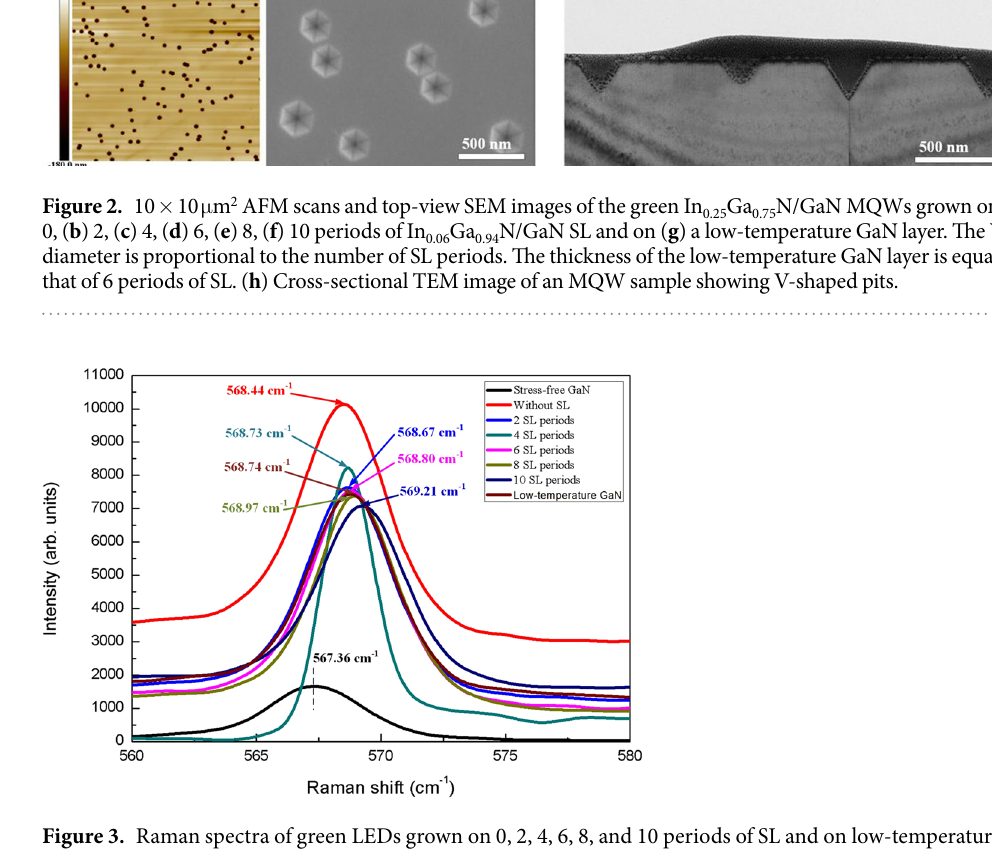
Figure 3. Raman spectra of green LEDs grown on 0, 2, 4, 6, 8, and 10 periods of SL and on low-temperature GaN. Dashed line indicates the stress-free GaN E 2 peak at 567.36 cm − 1